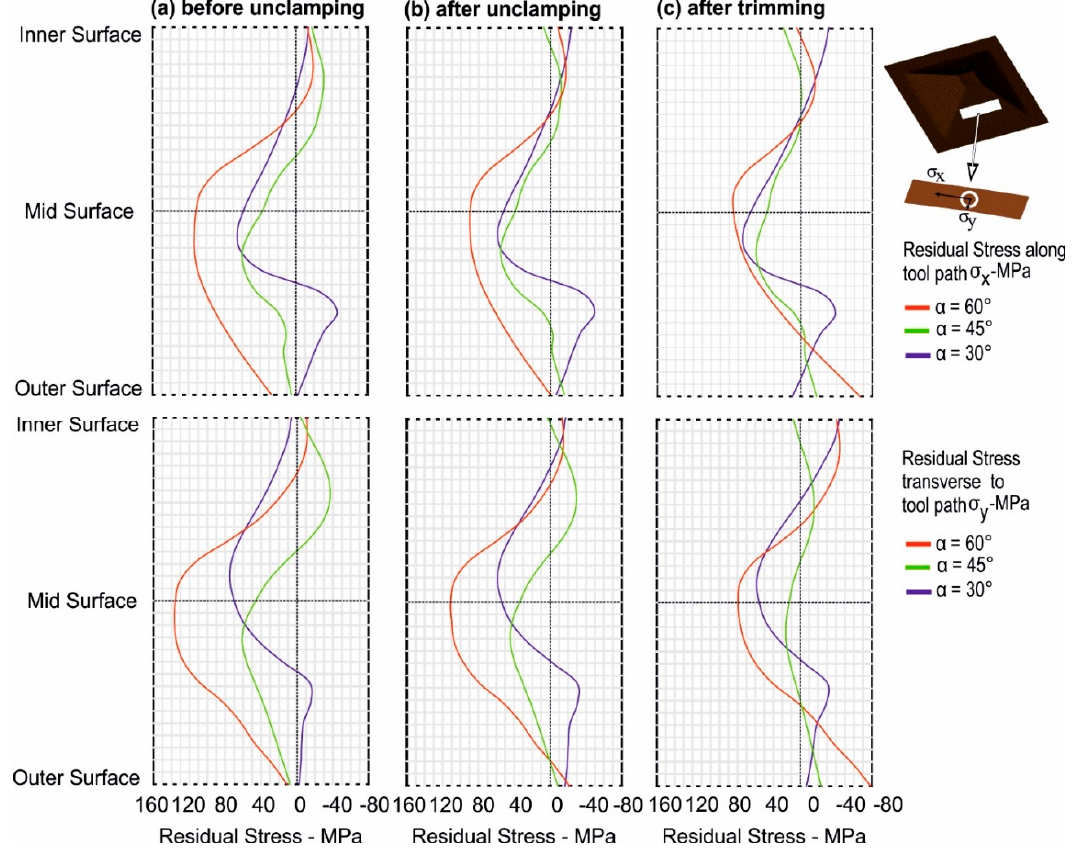
Figure 13. Distribution of the residual stresses in the center of the strip along and in the transverse direction of the tool motion for different wall angles: ( a ) before unclamping, ( b ) after unclamping, and ( c ) after trimming.